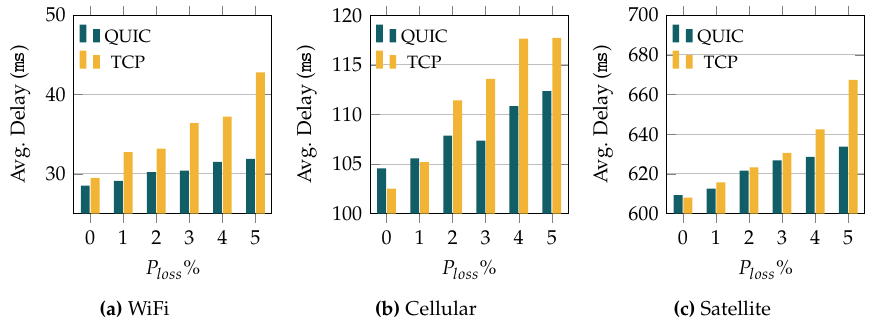
Figure 4. Average delay observed for QUIC and TCP, and different loss probabilities.